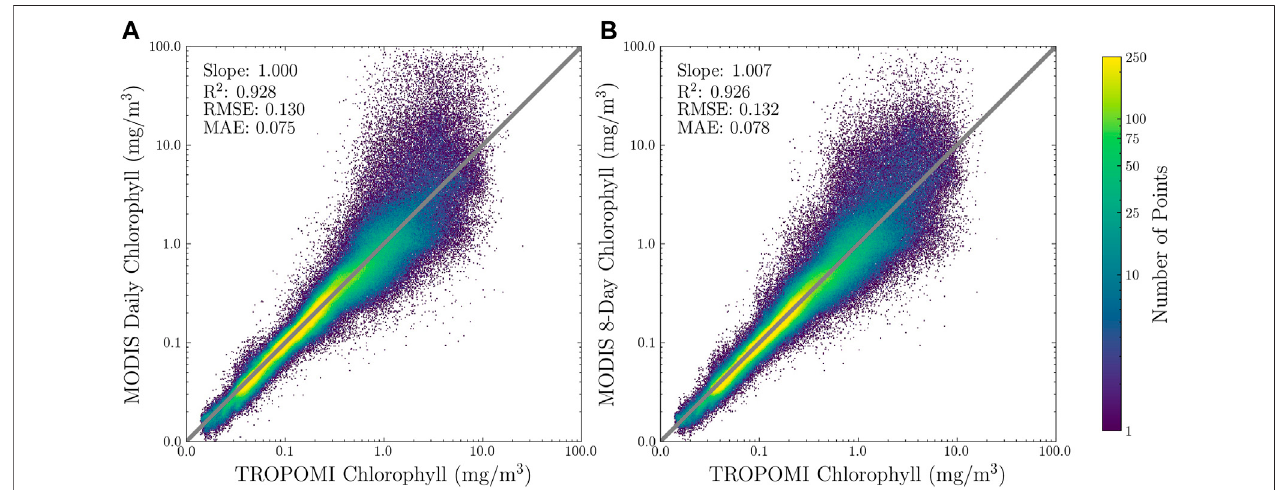
FIGURE6| ComparisonsofchlorophyllfromtheTROPOMINN-basedmethodandMODISatmosphericcorrection-basedretrievalfor15October2020.Statistics are shown for Log 10 of Chl. (A) Comparisons of TROPOMI NN-based chlorophyll with MODIS daily chlorophyll co-located to the TROPOMI FoV, (B) same as left but comparing with MODIS 8-day composite chlorophyll retrievals co-located to TROPOMI FoV.